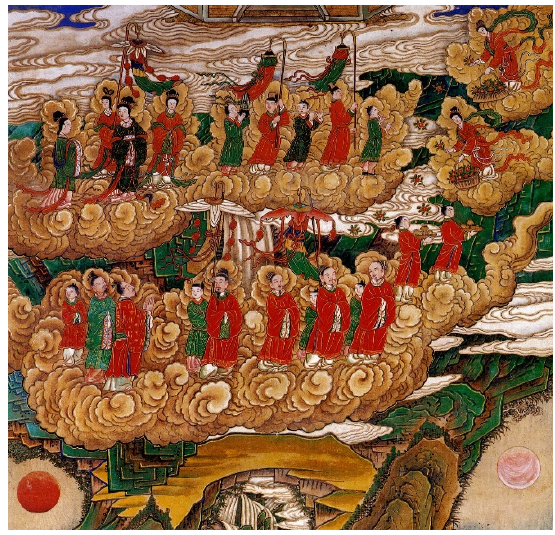
Figure 19. Detail of Three Gates in a Single Mind showing the scene of good men and women’s ascent to the heavenly palaces in the left frame. After (Sŏngbo Munhwajae Yŏn’guwŏn 1997, p. 186).